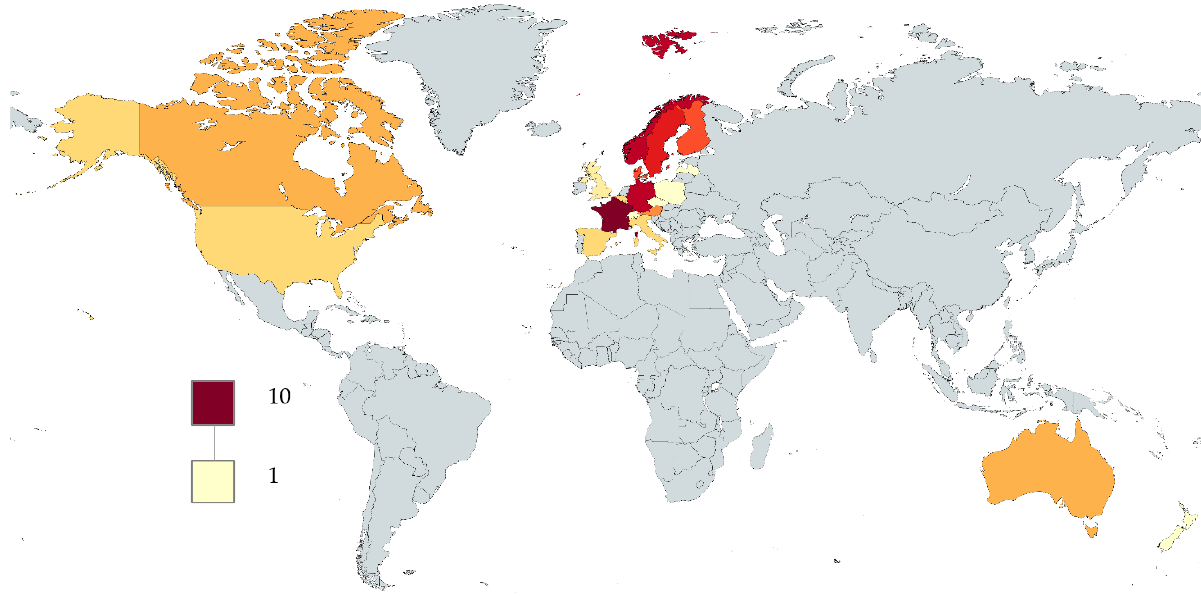
Figure 5. Heat map of the country of origin of the 81 EPDs on structural wood products. Graphic made with mapchart.net.